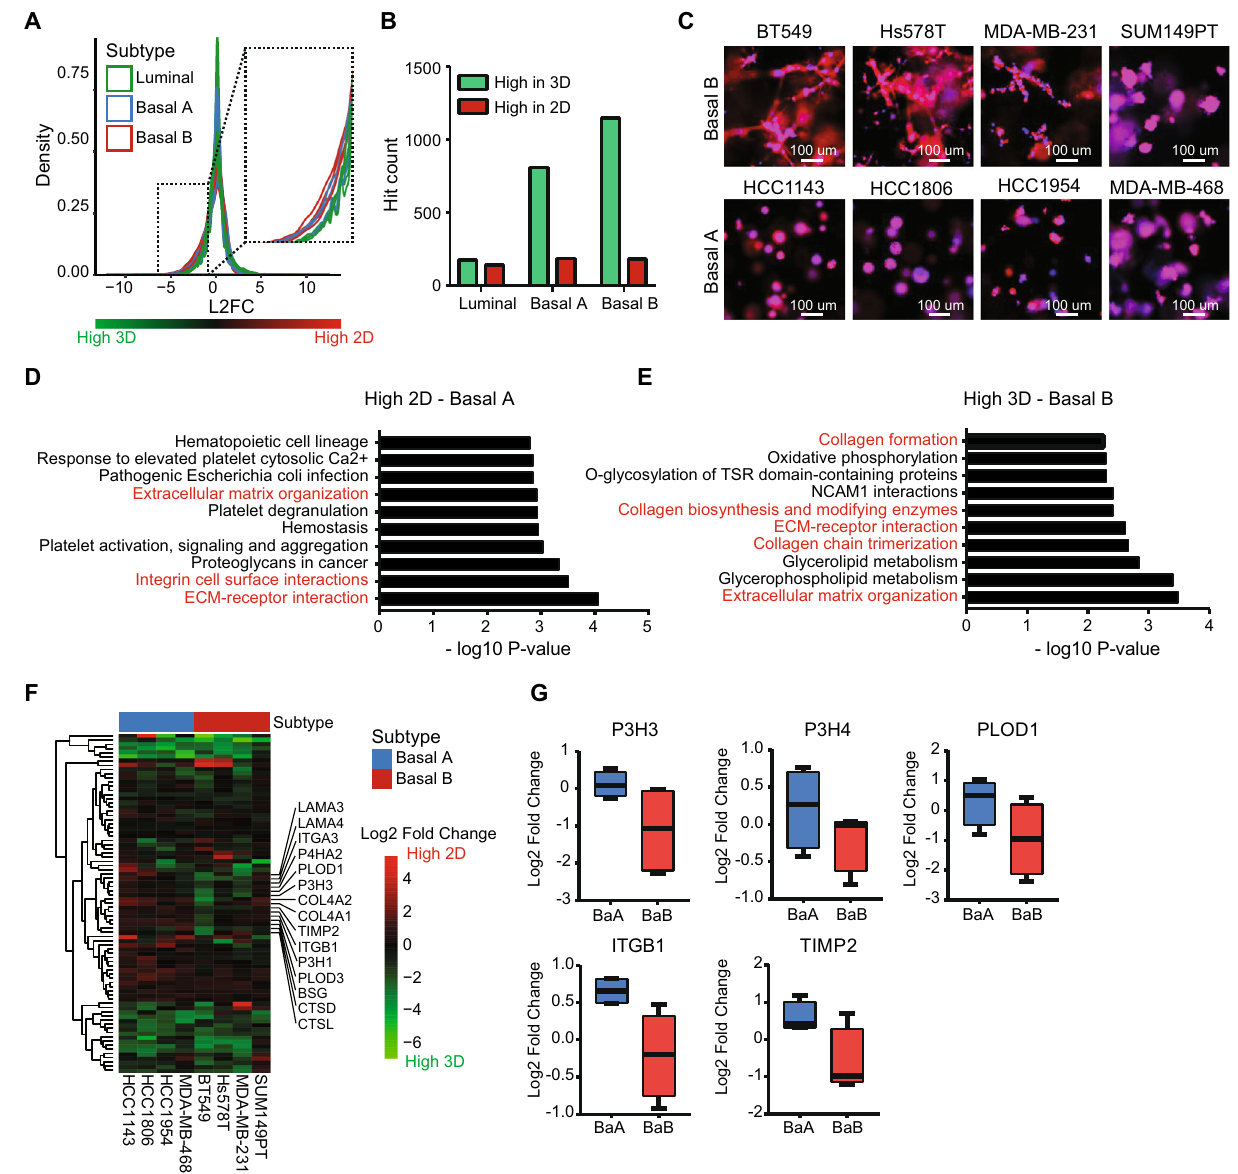
Figure 2. Subtype specific differences in 2D and 3D breast cancer cultures. ( A ) Density plot of log2 fold change in gene expression comparing 2D to 3D cultures of 14 cell lines (4 basal A, 4 basal B and 6 luminal). ( B ) Significantly DEG count for different subtypes based on paired analysis and p < 0.01. ( C ) Cellular morphology of basal A and basal B cell lines cultured in 3D. ( D ) Top 10 over-represented pathways in the high 2D DEGs in basal A cell lines. Migration and invasion related pathways are highlighted in red. DEGs were determined by paired analysis of basal A cell lines, p < 0.01. ( E ) Top 10 over-represented pathways in the high 3D DEGs in basal B cell lines. Migration and invasion related pathways are highlighted in red. DEGs were determined by paired analysis of basal B cell lines, p < 0.01. ( F ) Heatmap (complete linkage, Euclidean distance) of log2 fold change in expression of genes in the extracellular matrix organization pathway comparing 2D to 3D cultures. ( G ) Log2 fold change of expression levels of genes in the extracellular matrix pathway comparing 2D to 3D cultures in basal A and basal B cell lines. Selected genes were higher expressed in 2D in the basal A cell lines, but higher expressed in 3D in the basal B cell lines. Log2 fold change was determined using a paired analysis per